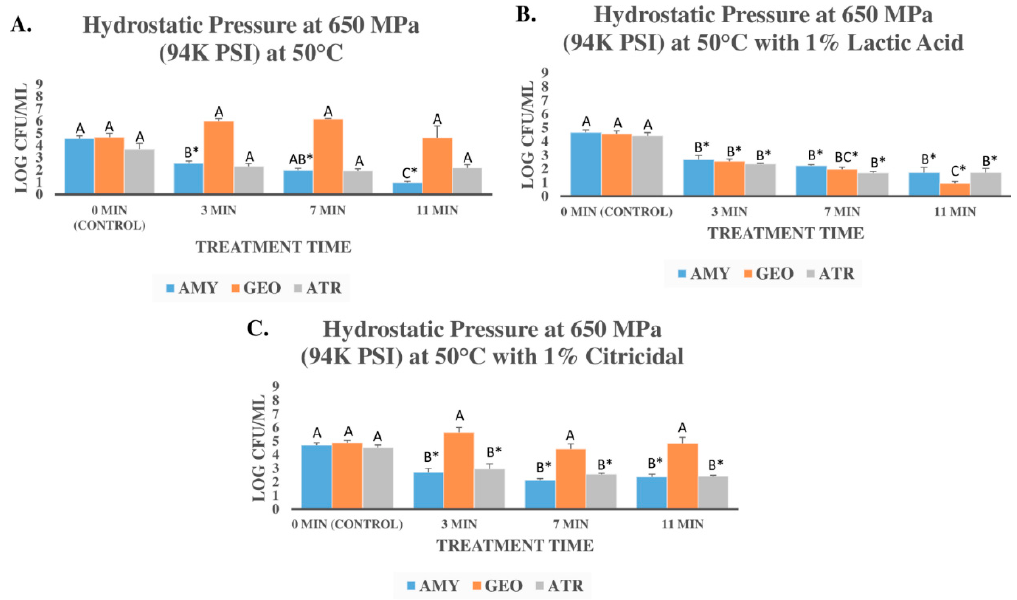
Figure 2. Inactivation of Bacillus amyloliquefaciens (AMY), Geobacillus stearothermophilus (GEO), and Bacillus atrophaeus (ATR) treated with the elevated hydrostatic pressure of 650 MPa at 50 °C in distilled water. ( A. ) Treatments without any added antimicrobial. ( B. ) Treated with elevated hydrostatic pressure of 650 MPa at 50 °C with 1% ( v / v ) lactic acid. ( C. ) Treated with the elevated hydrostatic pressure of 650 MPa at 50 °C with 1% ( v / v ) Citricidal TM . For each panel of the figure and each bacterium separately, columns followed by different uppercase letters are statistically ( p < 0.05) different from each other (Tukey-adjusted ANOVA). Columns followed by * sign are statistically ( p < 0.05) different from the control (Dunnett’s-adjusted ANOVA).